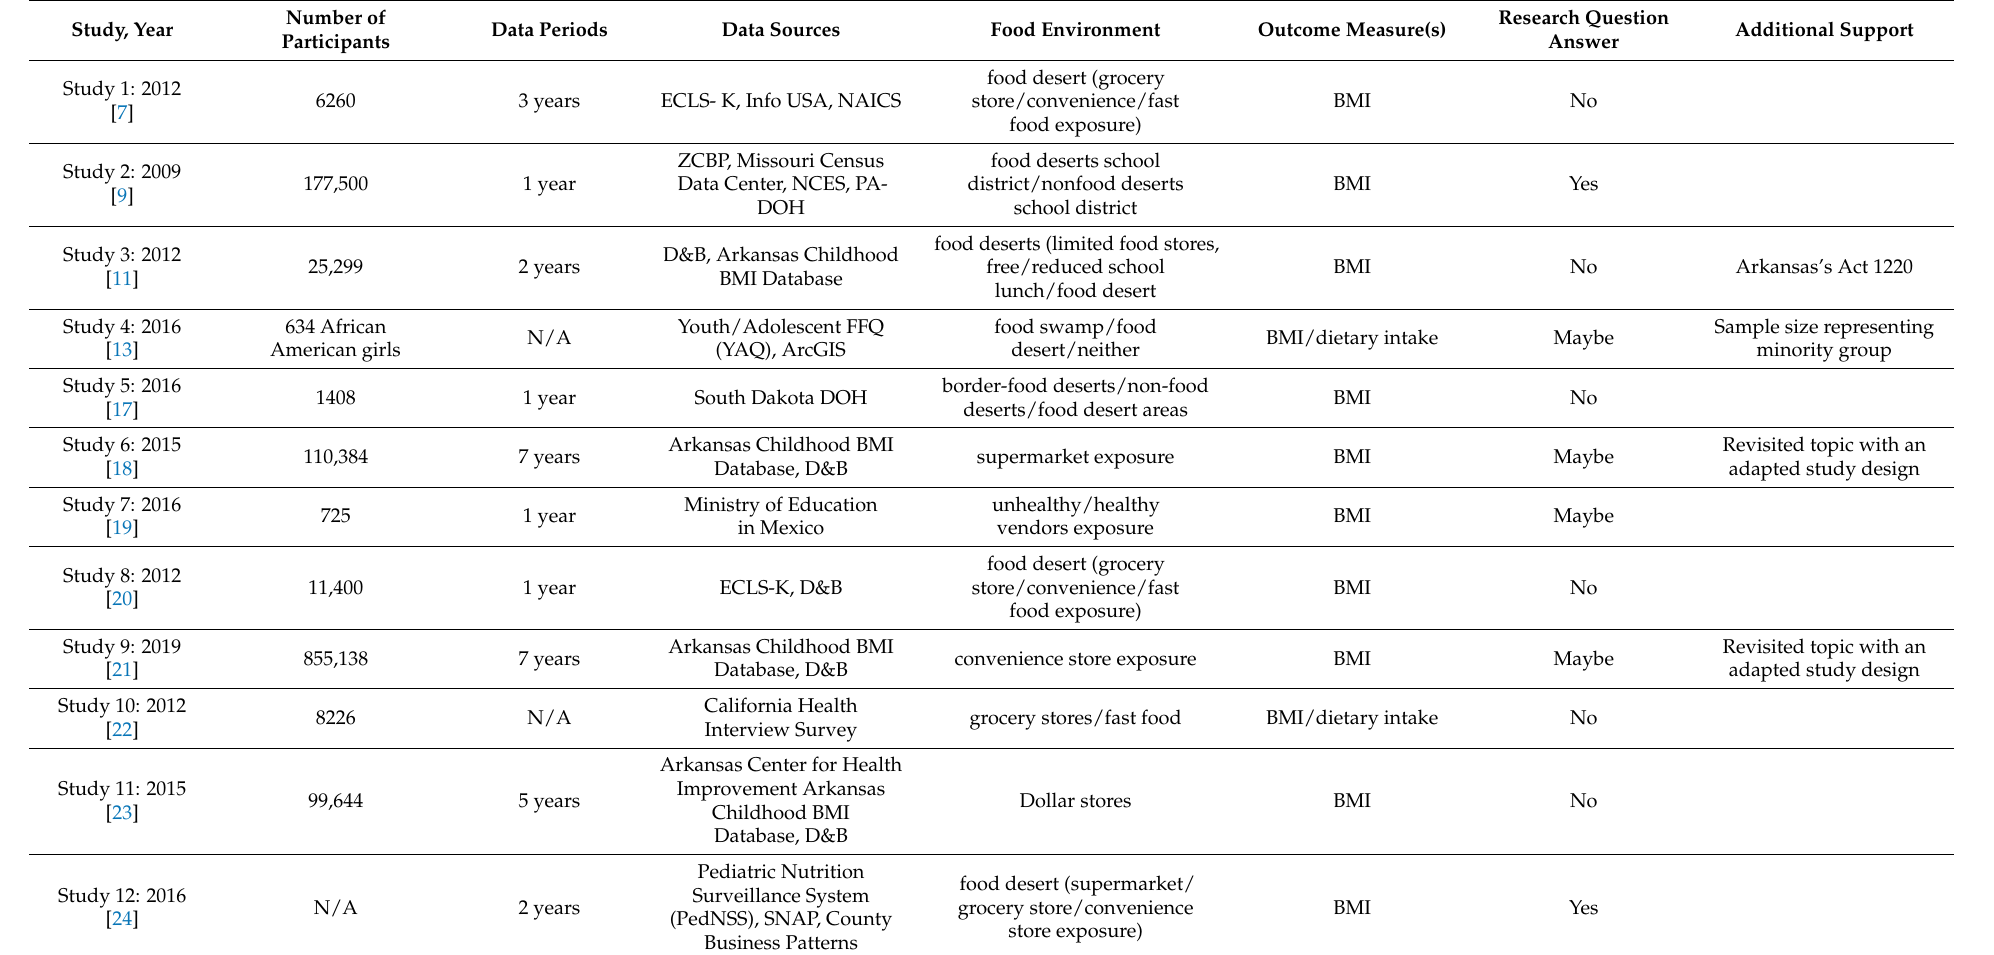
Table 1. A summary of the selected studies and important